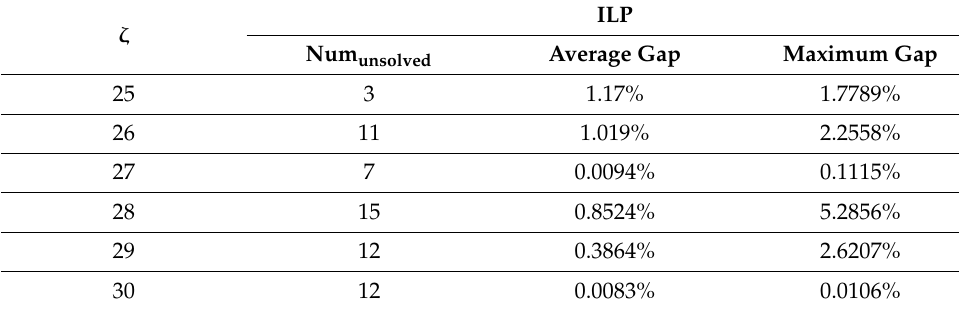
Table 3. Gaps between current solutions and lower bounds of optimal